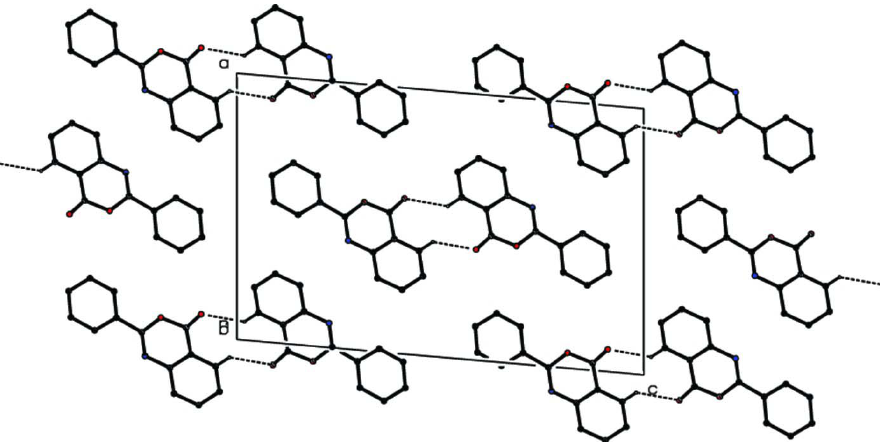
The molecular structure of the title compound, with atom labels and 50% probability displacement ellipsoids for non-H atoms.